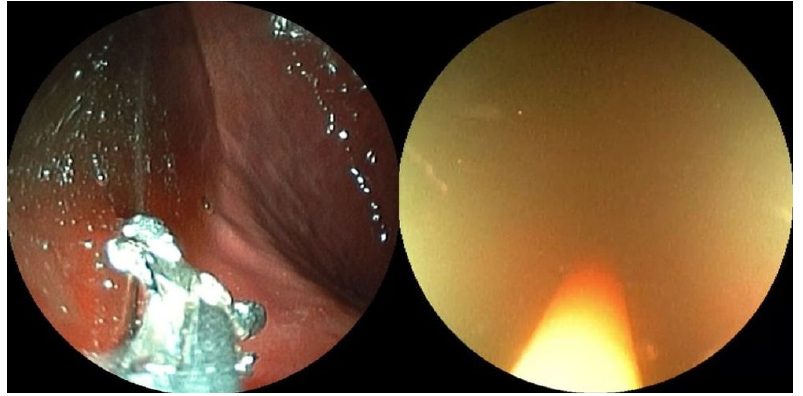
Figure 7. A continuous clear view is achieved by using biopsy forceps to push the mucosa. Step 5: Successful suction was completed when the mucosal membrane hidden by the GI residue appeared on the greater curvature side (Figure 8).